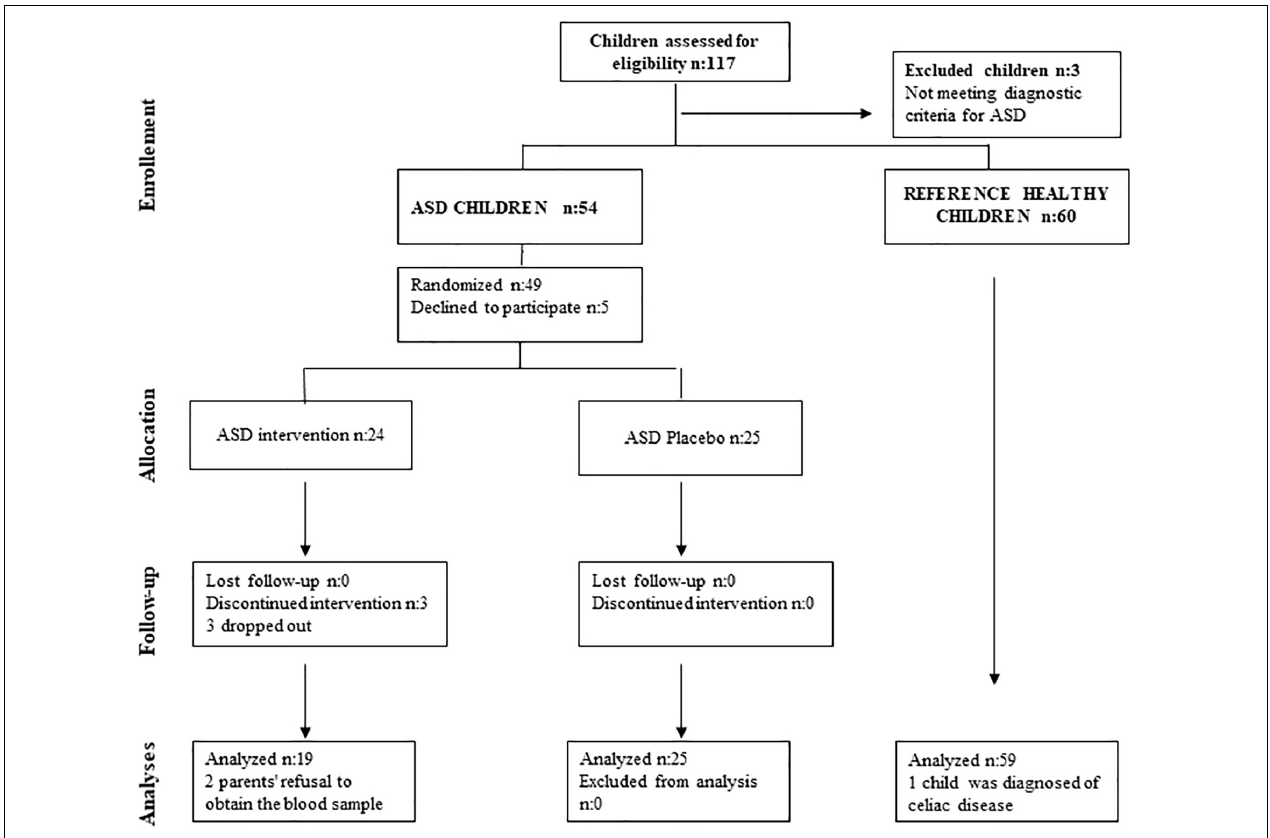
FIGURE 1 | Flow chart for participants and treatment arm allocation according to CONSORT